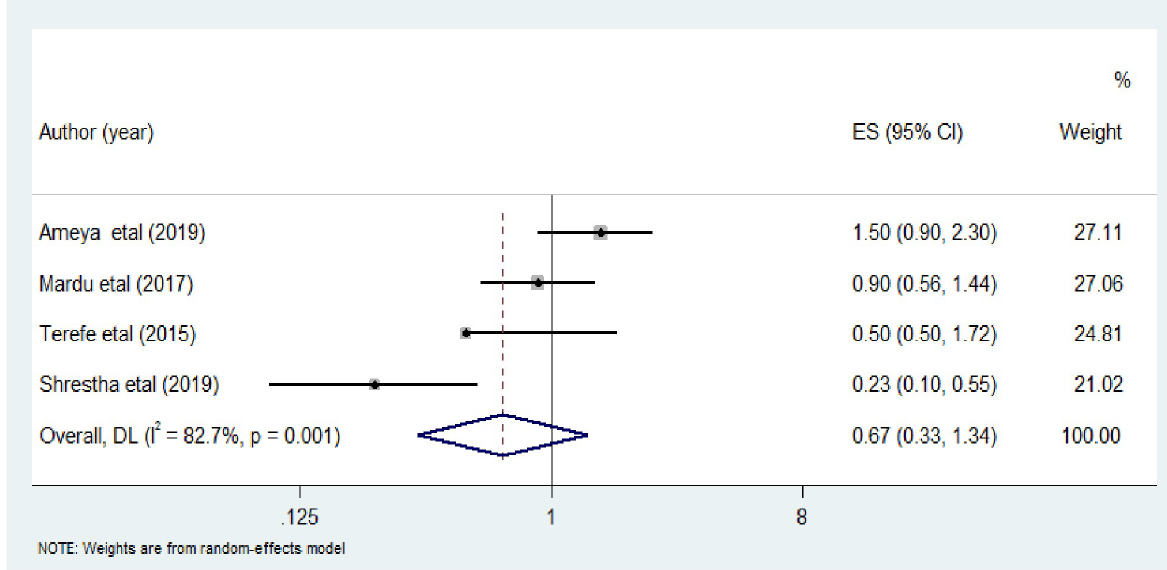
Fig 7. The pooled odds ratio of the association between residence and intestinal parasitic infection among street dwellers and prison inmates.